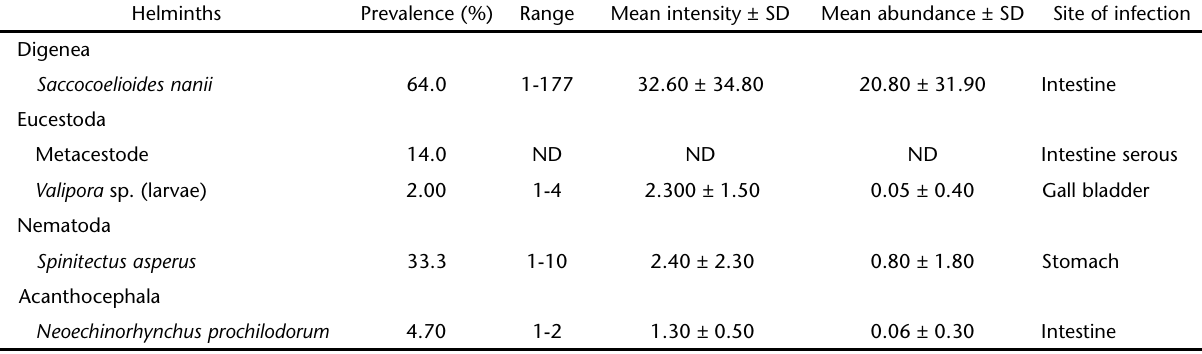
Table I. Helminths and their parameters of infection of P. argenteus from the Upper São Francisco River, Minas Gerais. (SD) Standard deviation.